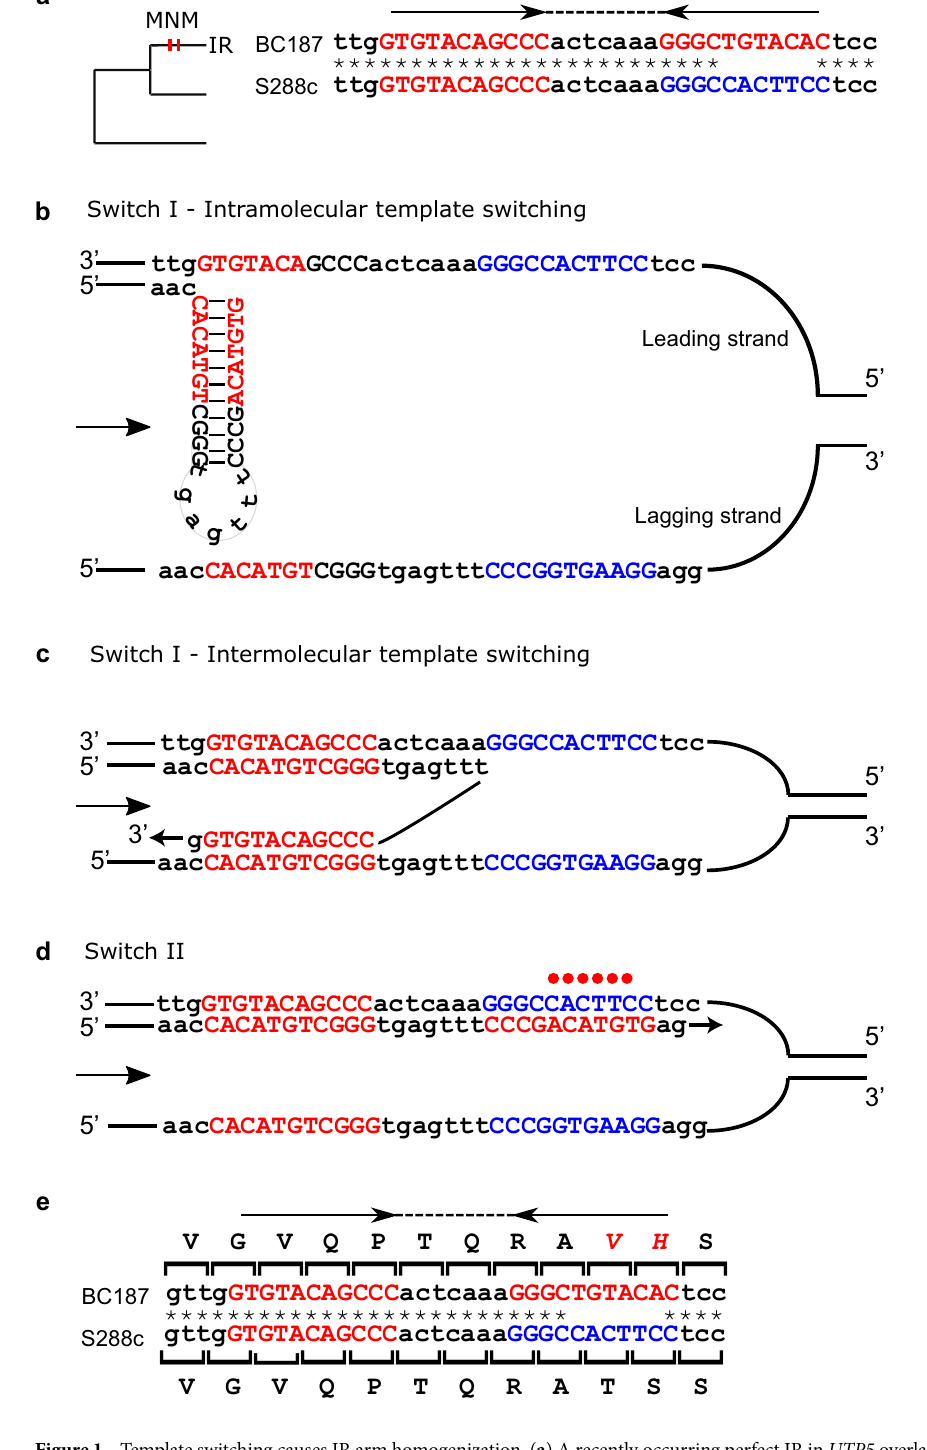
Figure 1. Template switching causes IR arm homogenization. ( a ) A recently occurring perfect IR in UTP5 overlapped with a MNM on the branch leading to BC187 (shown as vertical red lines on the branch). Alignment of BC187 (perfect IR) and S288c (imperfect IR) is shown, with arrows representing IR arms, the dotted line representing the IR spacer and asterisks representing matches between strains. A very short IR with an arm length of 4 bp and a spacer of 7 bp appears in S288c. In strain BC187, a longer IR with an arm length of 11 bp was formed. ( b – d ) Template switching converted an imperfect IR to a perfect IR. ( b ) Assuming intramolecular template switching, the nascent strand folded on itself and served as a template. ( c ) Assuming intermolecular template switching, the nascent strand invades the sister chromatid and uses it as a template. ( d ) The second switch returns the nascent strand into the original template, resulting in a perfect IR, represented by the upper sequence in A. Uppercase letters represent the IR arms, with the same arms colored in the same color. The red dots represent mismatches between the arms. The direction of the replication fork is indicated by an arrow. ( e ) Six substitutions were induced during the template switching, resulting in the replacement of two amino acids (T38V,